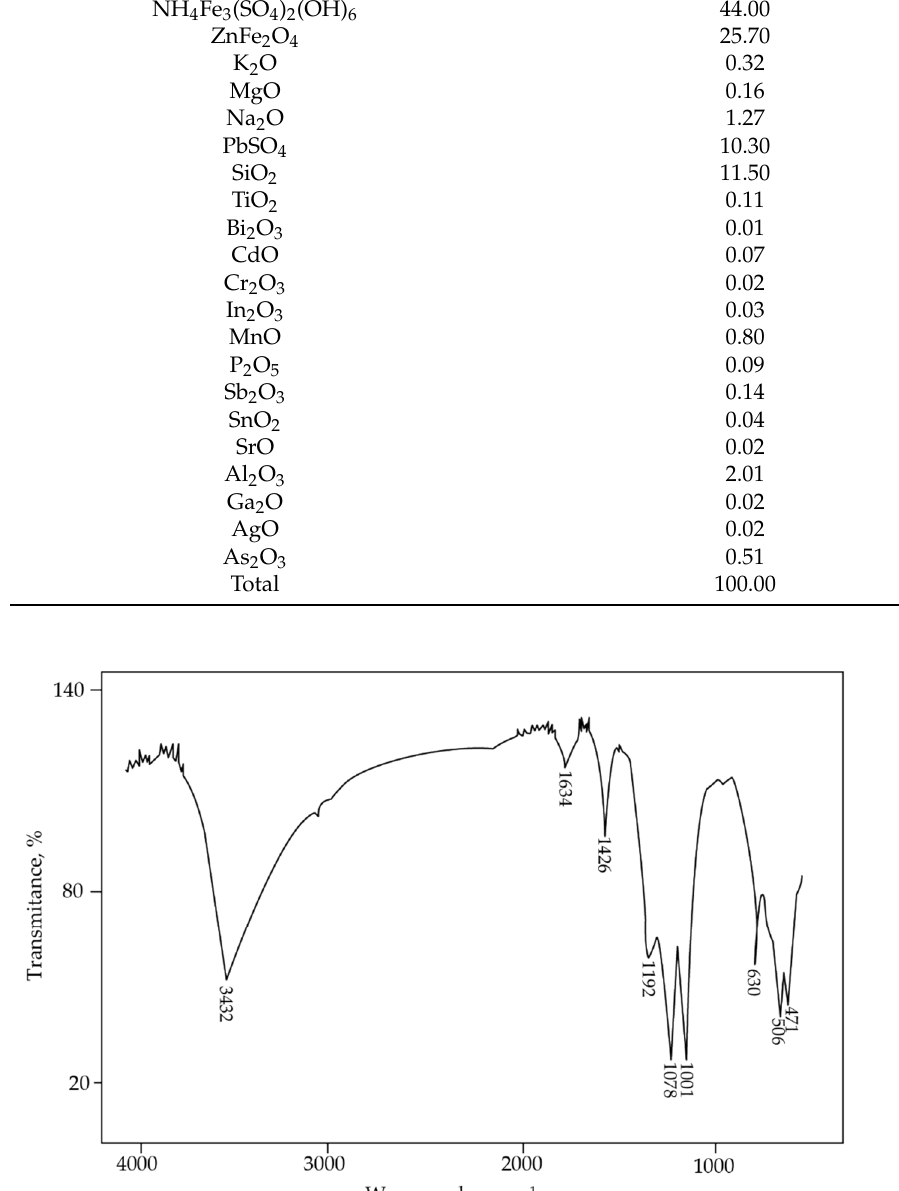
Figure 6. Particle size distribution and the cumulative size distribution of jarosite-PbAg sludge.